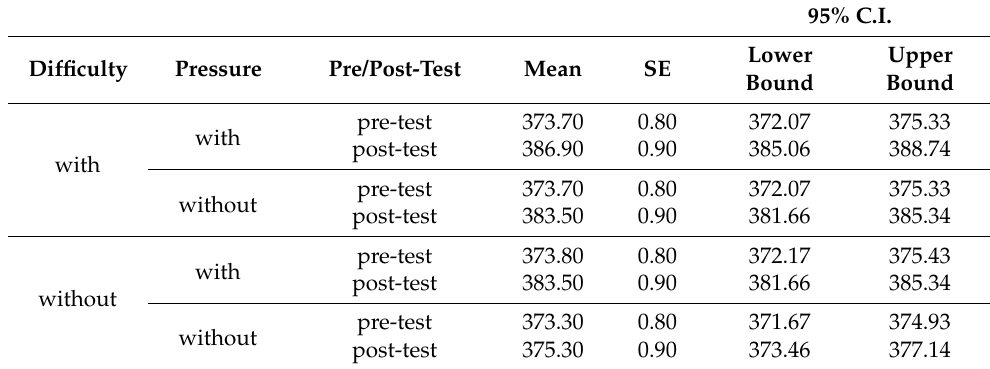
Table 7. Estimated marginal means of D-CAT- Interaction of difficulty * pressure * pre/post-pest.